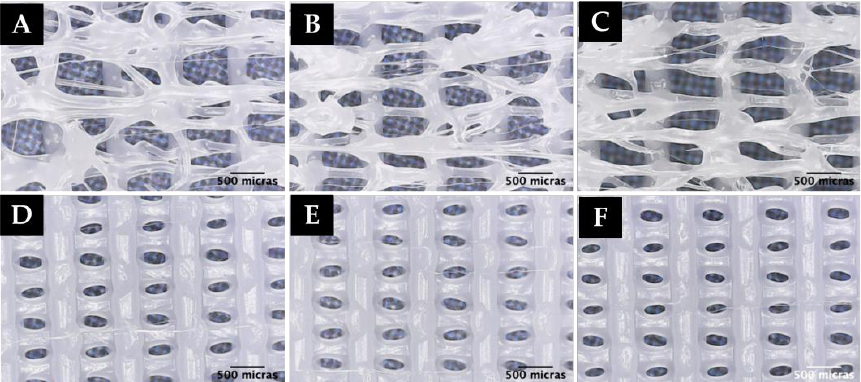
Figure 11. Microscope images of: ( A – C ) Reproducibility experiment T9B (4200 mm/min, PWM 255 and f = 0.45), ( D – F ) Reproducibility experiment P3B (4200 mm/min, PWM 255 and f = 0.20).